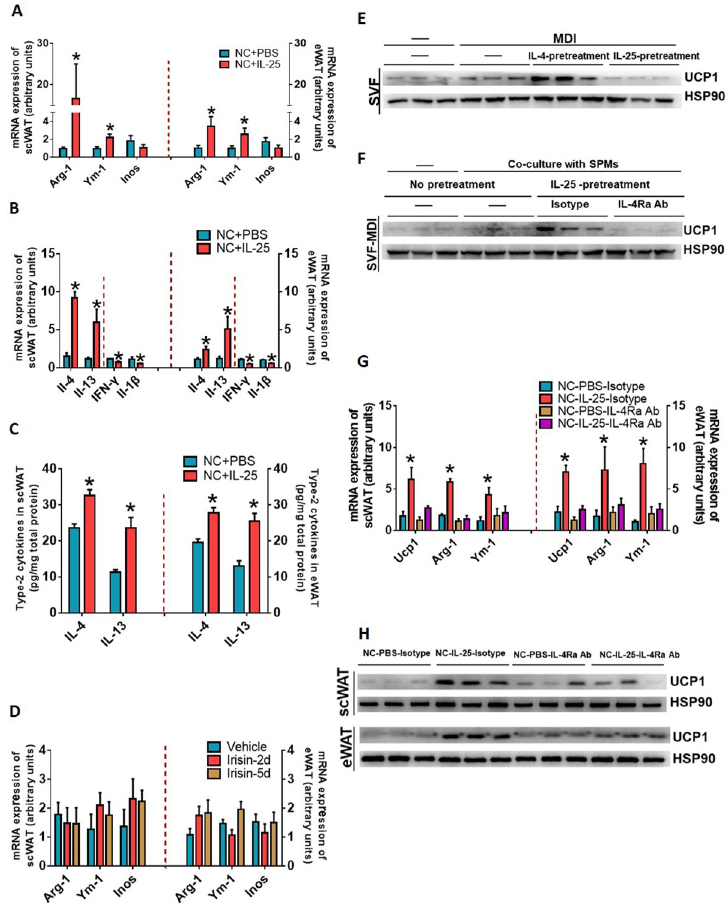
Fig 3. IL-25 stimulated IL-4/IL-13 release to promote the browning of adipose tissue via inducing alternatively activated macrophages. (A–C) C57/BL6J WT mice ( n = 5) were injected with vehicle or IL-25 (1 μ g/day) over 7 days and then (A) qPCR analysis of markers associated with macrophage polarization and (B) the mRNA expression of IL- 4/IL-13 or IFN- γ /IL-1 β genes in WAT. (C) IL-25 stimulates IL-4/IL-13 release in WAT. (D) C57/BL6J WT mice ( n = 4–5) were injected with vehicle or irisin (1 μ g/day) for 3 or 5 days, and genes associated with macrophage polarization were analyzed in WAT. (E) UCP1 examined by western blot in differentiated APs (MDI-induced SVF) pretreated with IL-4 (50 ng/ml) or IL-25 (50 ng/ml). (F) UCP1 examined by western blot in differentiated APs co- cultured with peritoneal macrophages stimulated with IL-25 (50 ng/ml) and anti-IL-4R α neutralizing antibody (50 μ g/ ml). (G, H) C57/BL6J mice ( n = 5) injected with vehicle or IL-25 (1 μ g/day) for 7 days and anti-IL-4R α neutralizing antibody (125 μ g/day) or isotype control were injected at day 1 and day 4. Real-time PCR analysis of mRNA level of Ucp1, Arg-1, and Ym-1 (G) and western blot analysis of UCP1 protein level in WAT (H). HSP90 was used as a loading control. � p < 0.05 by two-sided unpaired t test. Data present as mean ± SEM. The data underlying this figure can be found in S1 Data. AP, adipose precursor; eWAT, epididymal WAT; IL, interleukin; qPCR, quantitative PCR; scWAT, subcutaneous WAT; UCP1, uncoupling protein 1; WAT, white adipose tissue; WT, wild-type.